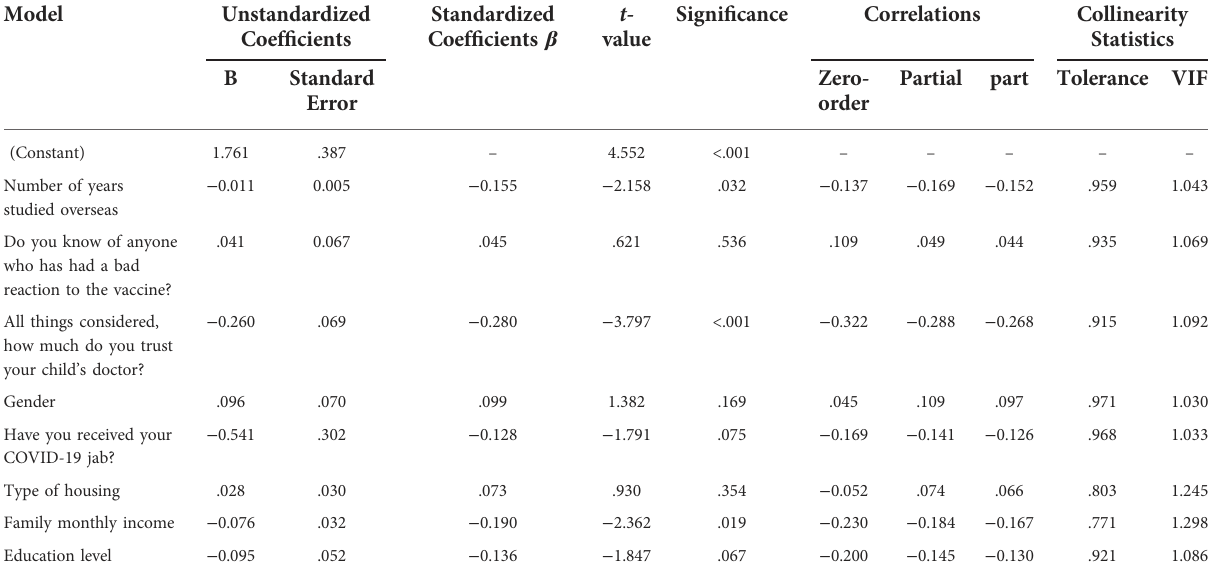
TABLE 3 Regression model used to determine vaccine hesitancy.